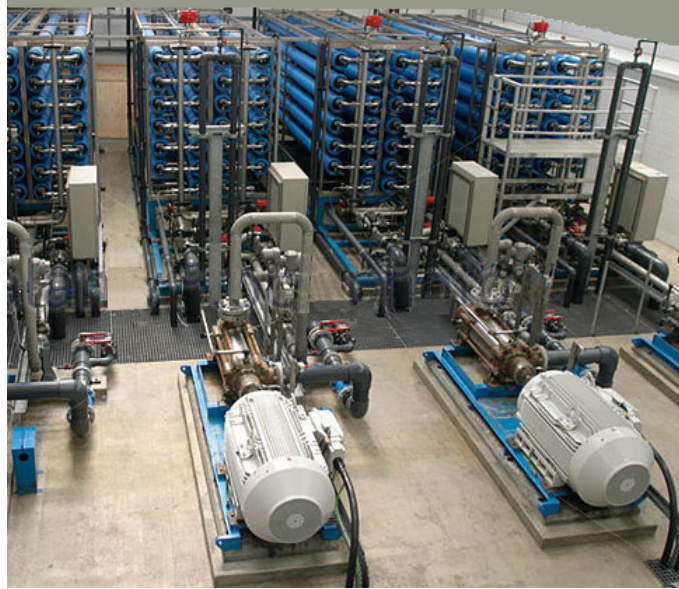
Figure 5. RO racks of an industrial seawater RO desalination